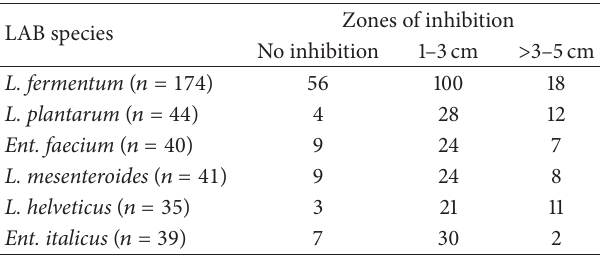
Table 2: Lipolytic activities of predominant LAB isolated from